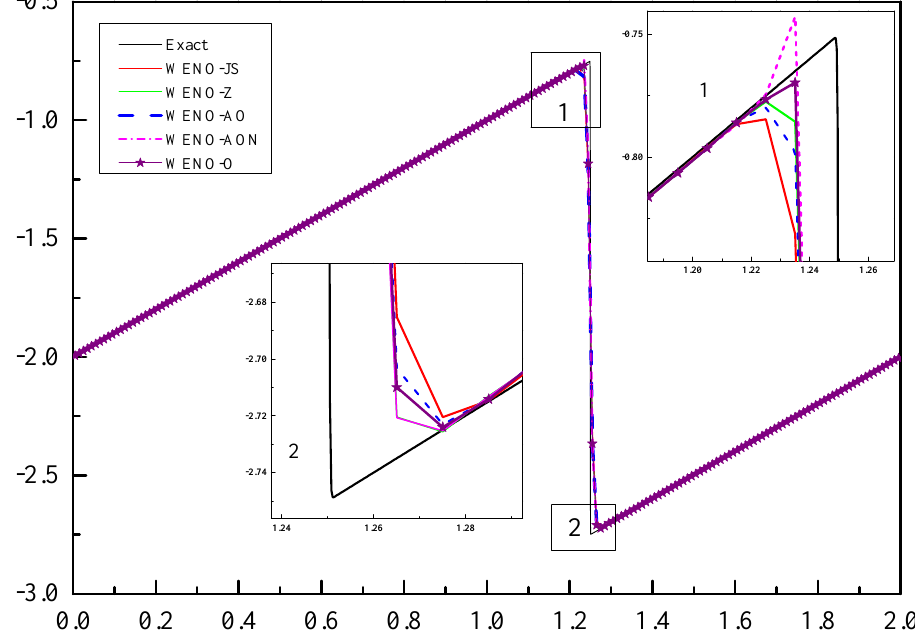
Figure 4. The accuracy comparison of WENO-O with WENO-AO, WENO-AON, WENO-Z, and WENO-JS schemes for Example 2 (Section 6.1.2) on uniform mesh at t = 1 and CFL = 0.1.